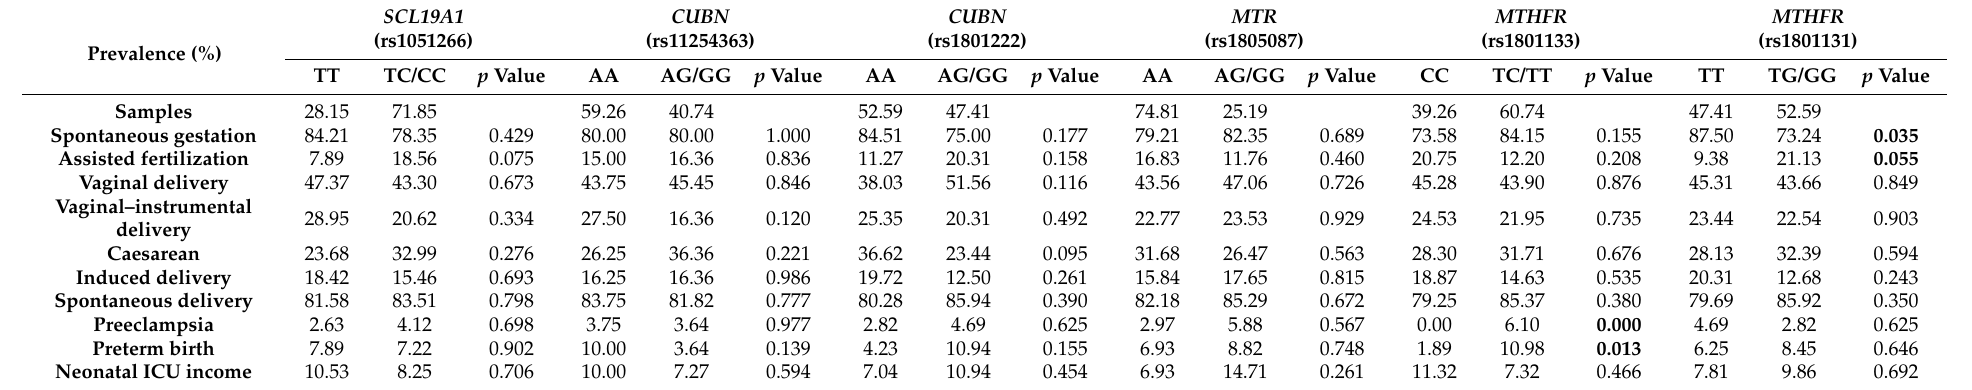
ICU, intensive care unit. AA, adenine-adenine genotype; AG, adenine-guanine genotype; GG, guanine-guanine genotype; TT, thymine-thymine genotype; TG, thymine-guanine genotype; CC, cytosine-cytosine genotype; TC, thymine-cytosine genotype; MTHFR, methylenetetrahydrofolate reductase; SLC10A1, reduced folate carrier (RFC1); MTR, methionine synthase; CUBN, cubilin. Numbers in bold show statistically significant